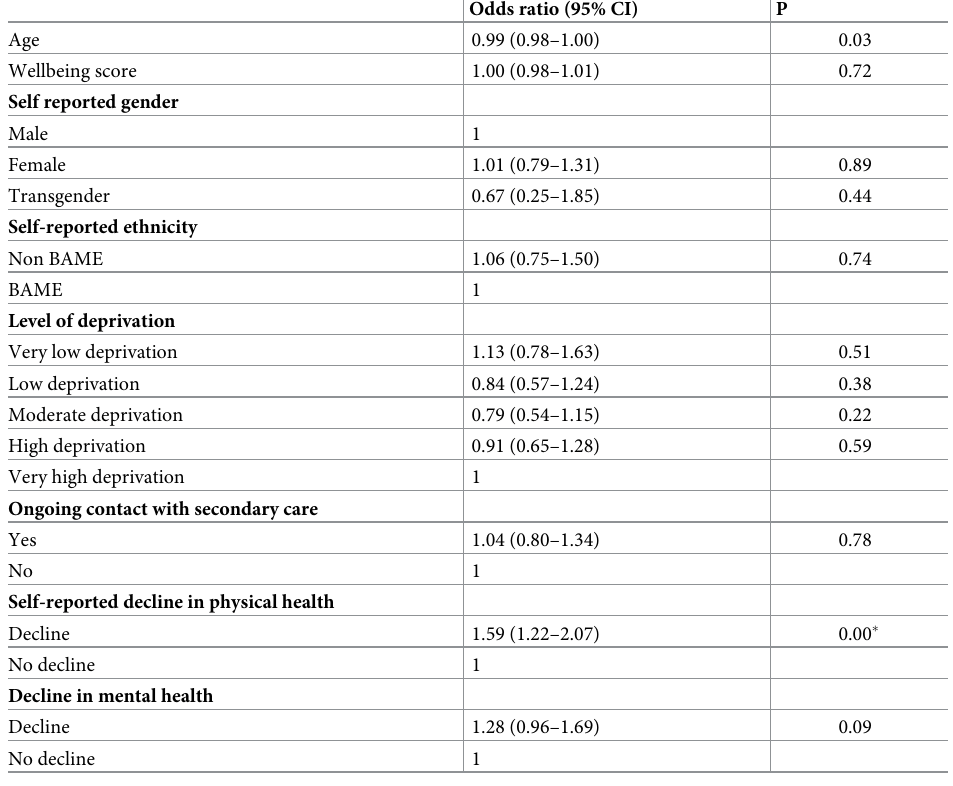
Table 4. Associations between socio-demographic factors, health related variables and behaviours known to be harmful to